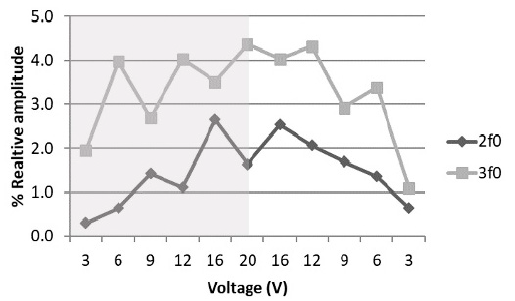
Figure 10. Dependence of relative amplitude of 2 f 0 and 3 f 0 , with respect to f 0 , with transducer excitation voltage variation when the voltage is increased (shaded region) or decreased (withe